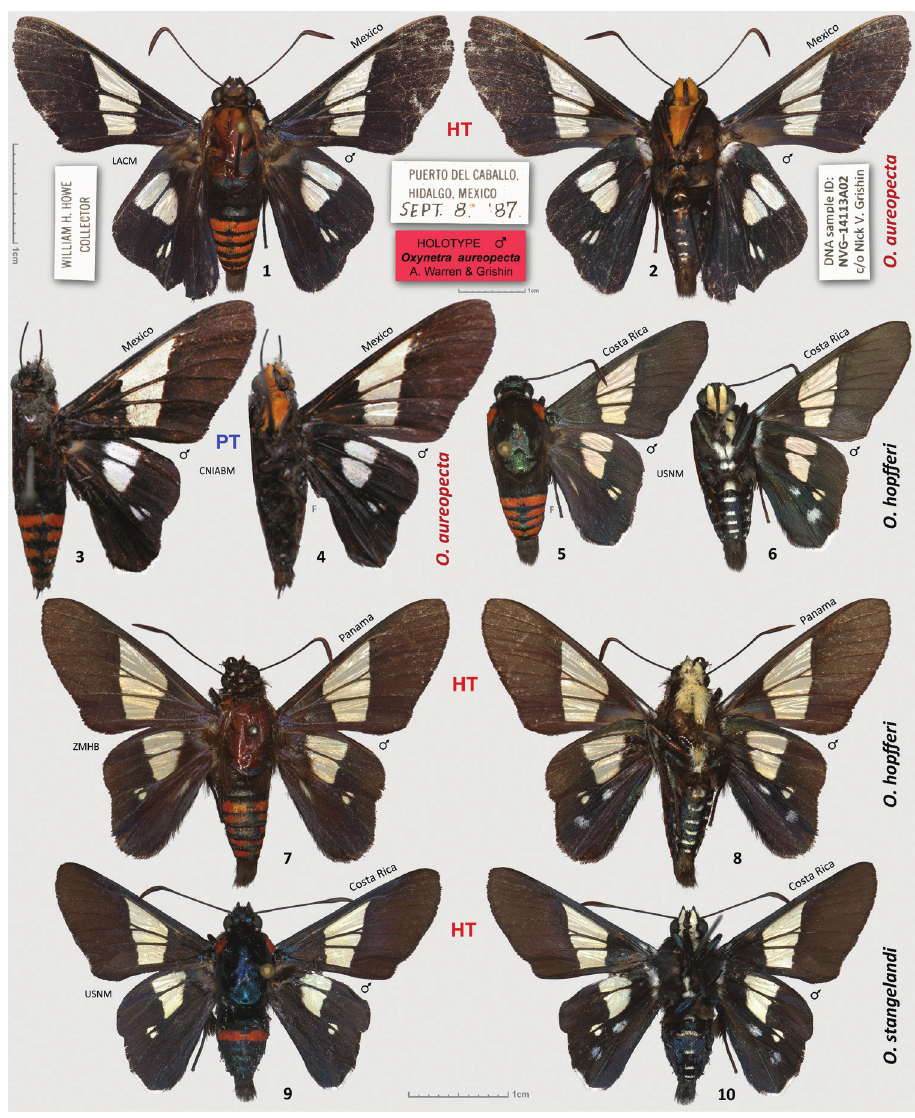
Figures 1–10. Males of Oxynetra . 1 – 4 O. aureopecta sp. n. holotype ( 1 – 2 ) and paratype ( 3 – 4 ), data in text 5 – 6 O. hopfferi , Costa Rica: Puntarenas, Monteverde, 1997, voucher 97-ZFuentes-055 [USNM] 7 – 8 O. hopfferi holotype, Panama: Chiriqui [ZMHB] 9 – 10 O. stangelandi holotype, Costa Rica: Gua- nacaste, eclosed on 19.VIII.2002, voucher 02-SRNP-23284 [USNM]. Dorsal and ventral surfaces are shown on odd- and even-numbered figures, respectively. Labels are shown for the holotype of the new species and are reduced 1.5 times compared to specimens: smaller scale bar above the top labels refers to labels, and larger scale bars refer to specimens. Pinholes and some imperfections have been removed to emphasize actual wing